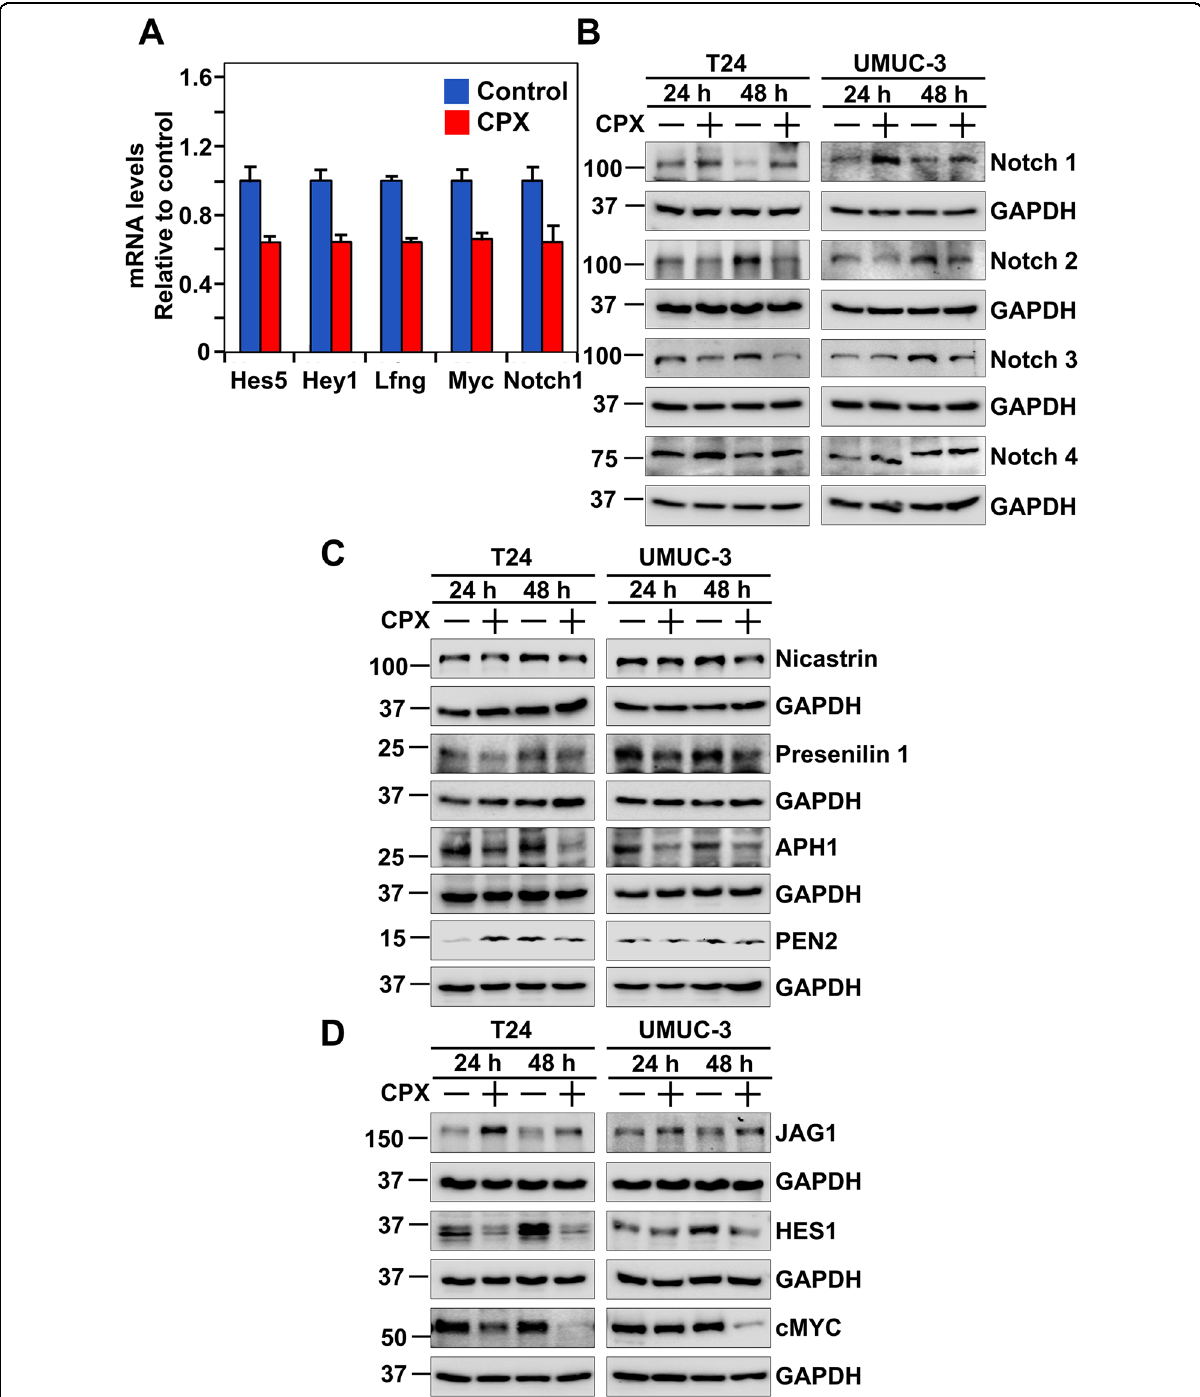
Fig. 5 CPX targets the Notch signaling pathway, through inhibition of the γ -secretase complex. A CPX inhibits mRNA expression of genes involved in Wnt, Hedgehog, and Notch cell signaling pathways. RNA extracted from T24 cells treated with and without CPX for 48 h was used to generate cDNA. The samples were analyzed using a Human stem cell RT2 pro fi ler PCR array to identify signaling pathways that important for stem cell maintenance like Notch signaling and Wnt signaling. Expression of Hes5, Lfng, Myc, and Notch 1 mRNAs were signi fi cantly downregulated after CPX treatment. B CPX affects the expression of Notch receptors. Western blot analysis demonstrates that CPX treatment increased the expression of Notch 1 and suppressed the activation of Notch 2 and Notch 3, while CPX has little to no effect on Notch 4. C CPX suppresses γ -secretase pathway proteins. Western blot analysis of CPX-treated T24 and UM-UC-3 cell lysates showed CPX treatment reduced levels of Nicastrin, Presenilin 1, APH-1, and PEN-2. D CPX suppresses notch signaling pathway ligand and downstream proteins. CPX increased the expression of ligand Jagged 1 and inhibited the expression of downstream targets Hes1, cMYC, and Cyclin D1 in T24 and UM-UC-3